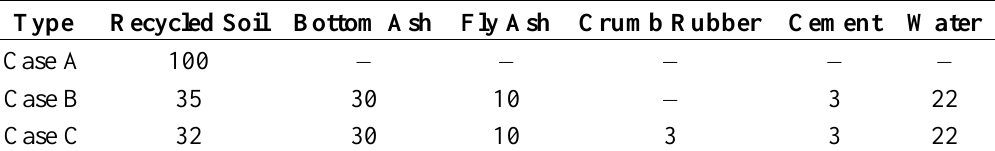
Table 7. The mixing composition (wt%).